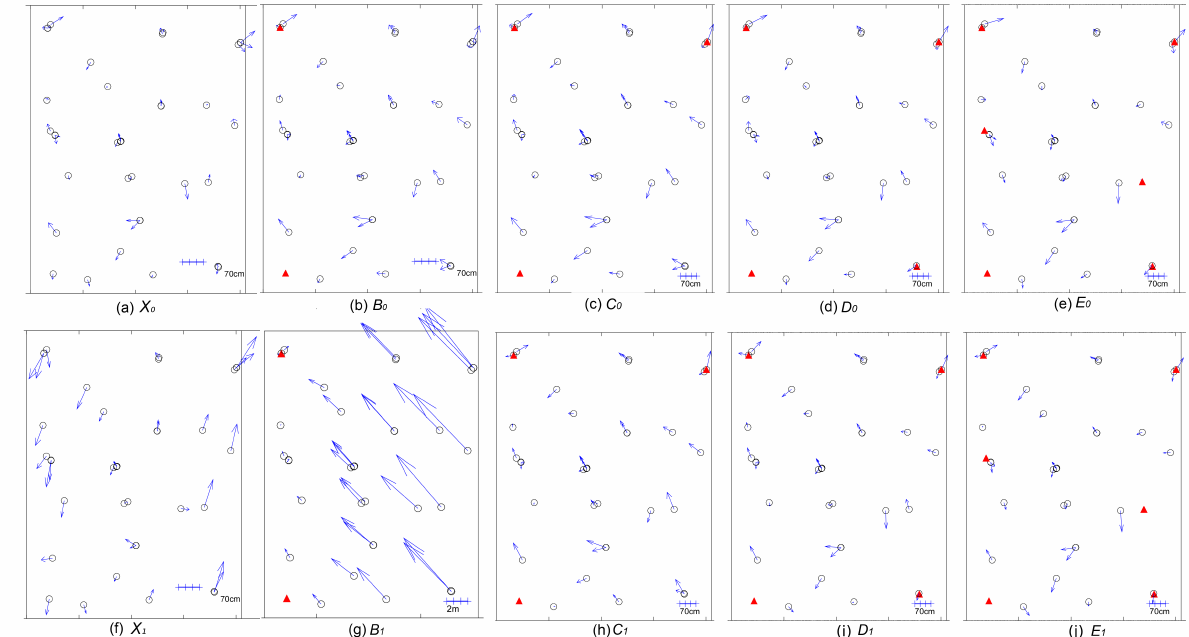
Figure 5: Limoge; BA results in different test scenarios. Red triangular markers correspond with the GCPs, the black circular markers are the CPs, and the vectors indicate the discrepancies between the BA-estimated and true values of control points in object space. Note the different scales in (g).